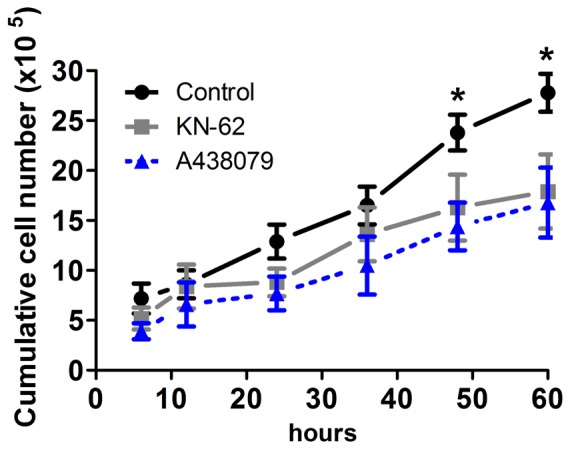
Inhibition of embryonic stem cell growth in the presence of P2X7R inhibitors.Cells were plated at 3X105 cell/ml density and P2X7R was inhibited daily with 10 µM KN-62 or 1 µM A438079 and then the number of cells were counted. Data represent mean values ±S.E. of three independent experiments performed in triplicate (*p<0,05 compared to control).